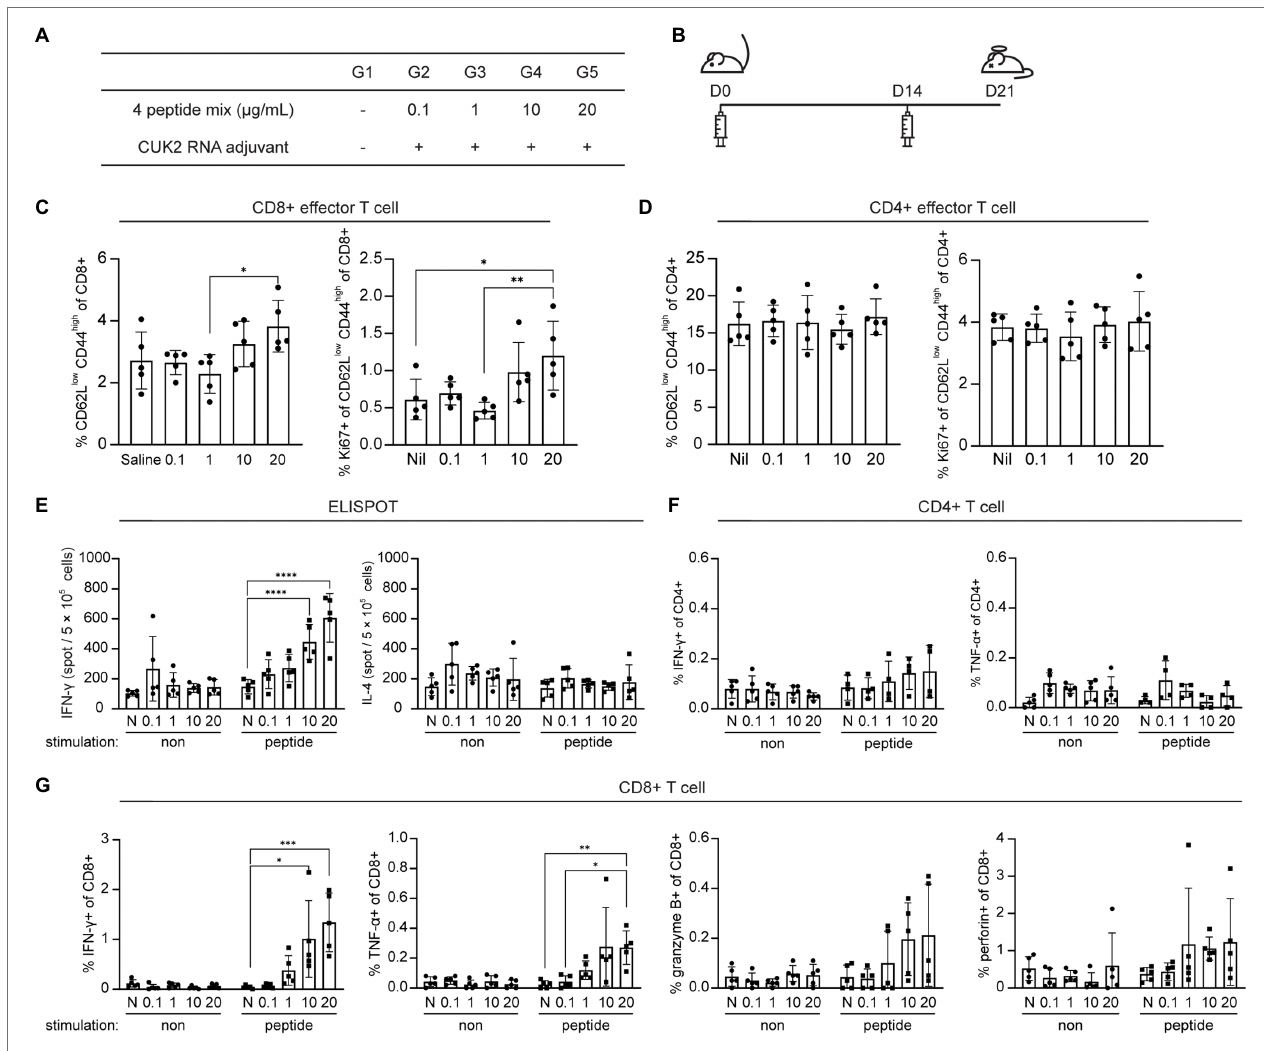
FIGURE 4 | Analysis of T cell activation after immunization with the four SARS-CoV-2 peptides and CUK2 RNA adjuvant. (A) Overview of the experimental groups. (B) Schedule of mice immunization. C57BL/6 mice were immunized twice at 2-week intervals with the four SARS-CoV-2 peptides mixture+ CUK2 RNA adjuvant and killed 1 week after the final immunization. (C) Percentages of CD62L low CD44 high T EM cells in the splenic CD8+ T cells and Ki67-positive cells in CD8 + CD62L low CD44 high T EM CD8 + T cells were analyzed using flow cytometry. (D) Percentages of CD62L low CD44 high T EM cells in the splenic CD4 + T cells and Ki67-positive cells in CD8 + CD62L low CD44 high T EM CD4 + T cells were analyzed using flow cytometry. (E) The number of four peptide mixture-specific IFN- γ - and IL-4-producing cells was quantified using ELISPOT. (F) IFN- γ - and TNF- α -producing cells in CD4 + T cells in response to four peptide mixtures were examined using flow cytometry. (G) IFN- γ - and TNF- α -producing cells in CD8 + T cells in response to four peptide mixtures were examined using flow cytometry. Data represent mean ± SD. * p ≤ 0.05; **